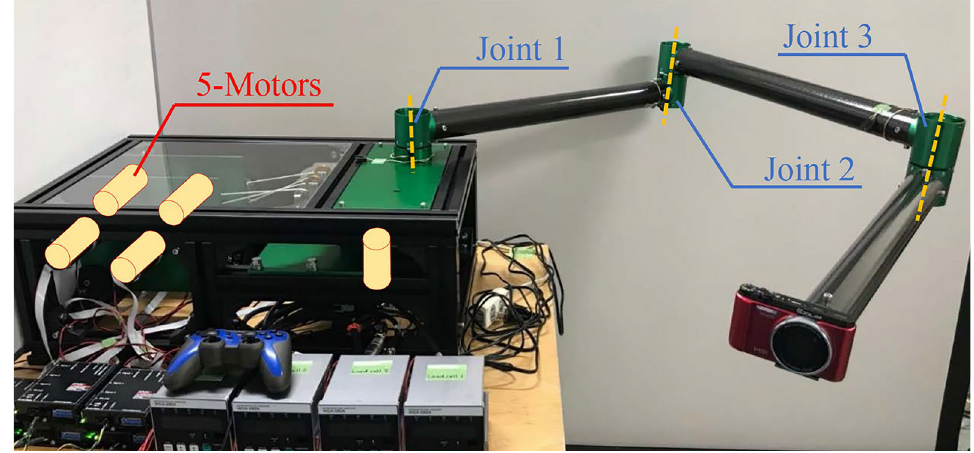
Fig. 2 The prototype bundled wire drive robot with three horizontal expandable Degree of Freedom [4]